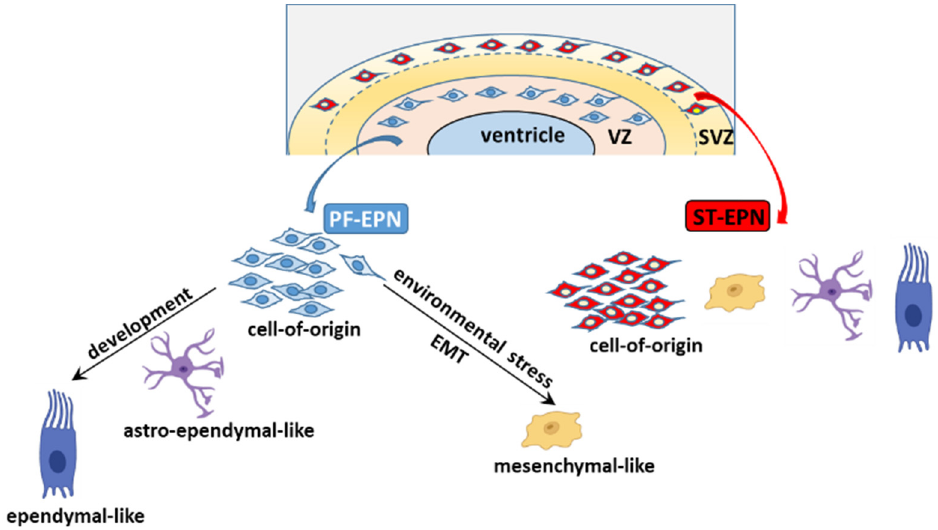
Figure 6. The candidate cell of origin of PF-EPNs resides in the ventricular zone (VZ) of the developing brain, whereas that of ST-EPNs is located in the subventricular zone (SVZ). In PF-EPNs, tumor subpopulations are arranged in two major distinct lineage trajectories driven by undifferentiated progenitors, that either undergo impaired differentiation towards ependymal-like cells, or transition to mesenchymal-like cells in response to cellular stresses, e.g., hypoxia. In ST-EPNs, clear developmental trajectories have not been identified yet (Reprinted with permission from Austin E. Gillen et al., (2020), Elsevier and Copyright Clearance Center, Licence Number 5200810483356, 2 December 2021) .